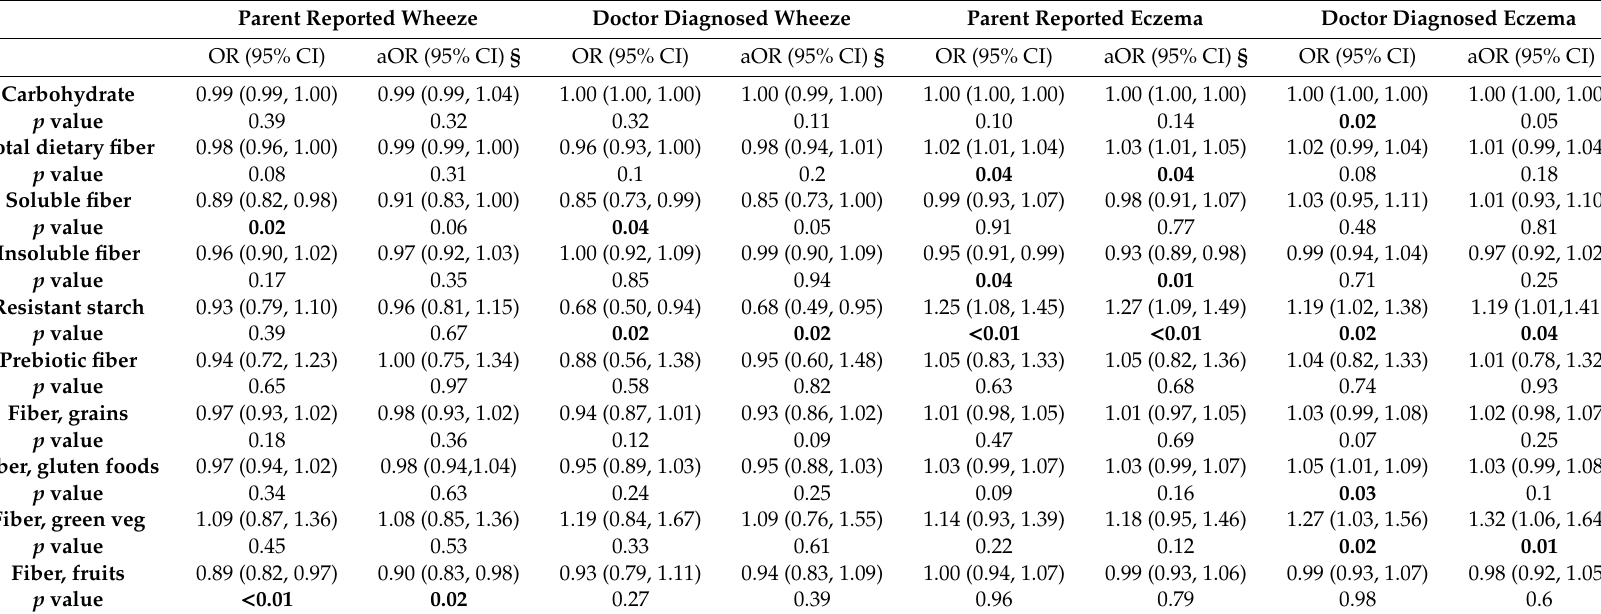
Table 5. Logistic regression analysis association between maternal dietary fiber intakes during late pregnancy and infant wheeze and eczema. Parent Reported Wheeze Doctor Diagnosed